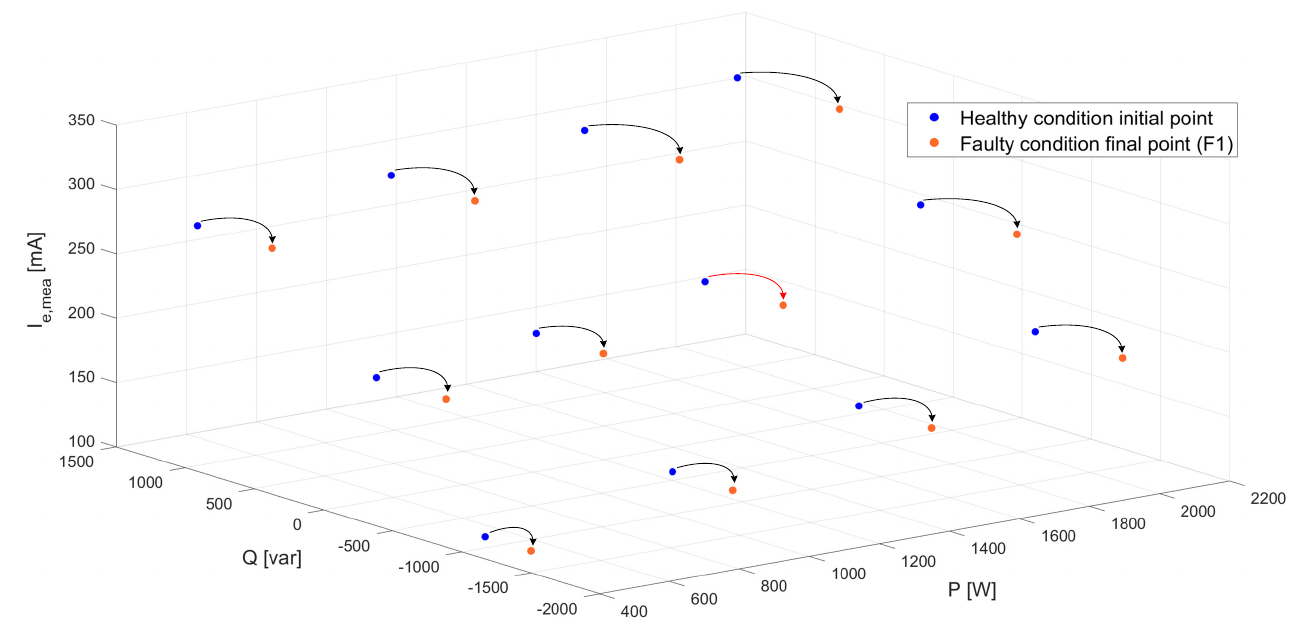
Figure 12. Experimental results. Representation of I e,mea for (P, Q) operating points at U = 400 V both in healthy conditions and in faulty conditions (F1: open-diode fault).